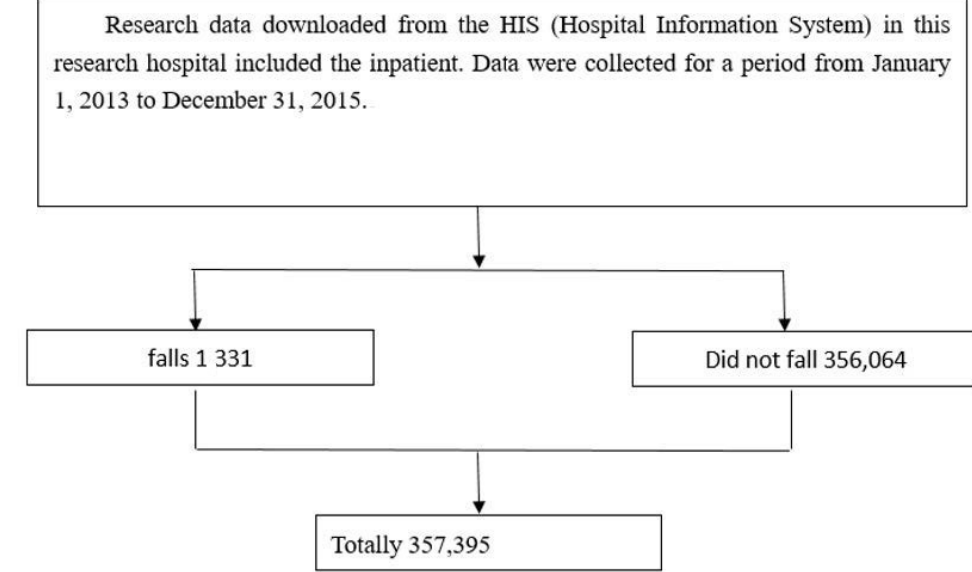
Figure 1. Flowchart of study subjects’ selection.